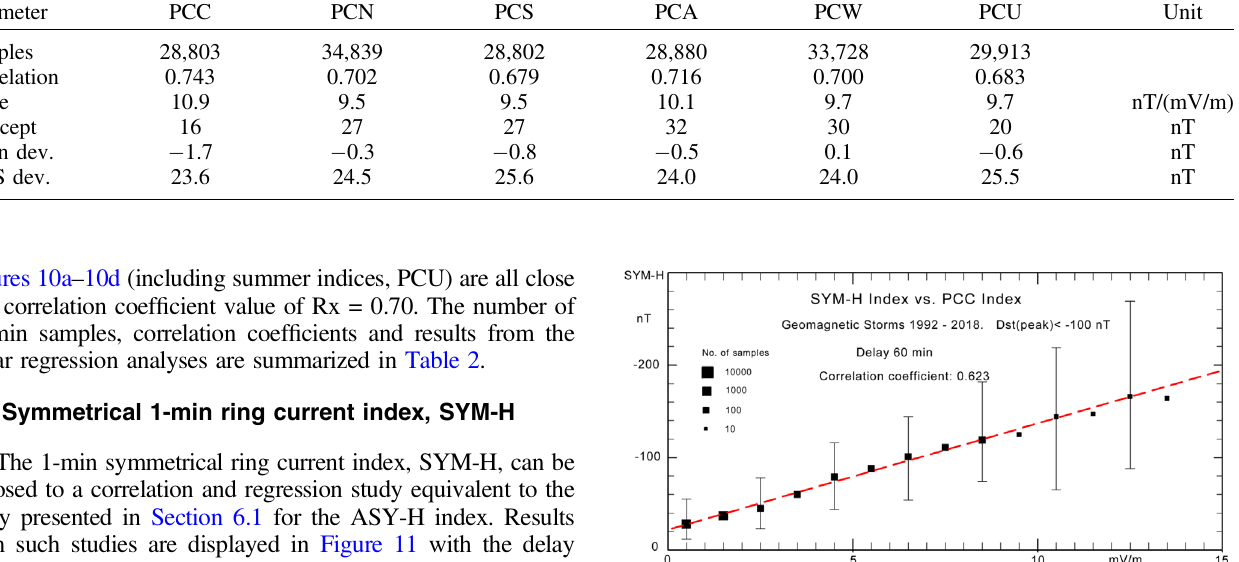
Fig. 11. Scatter plots for SYM-H vs. PCC in the format of Figure 9b with delay 60